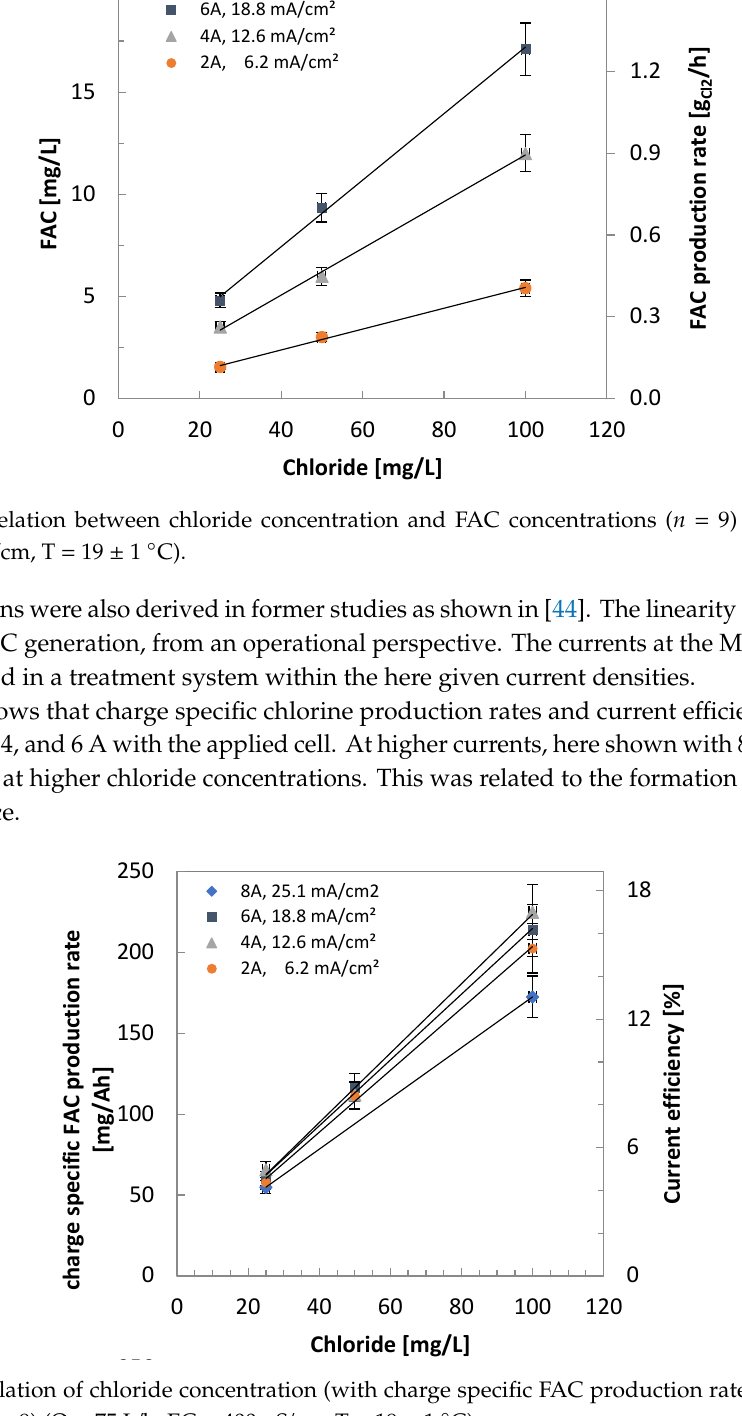
Figure 6. Relation of chloride concentration (with charge specific FAC production rate and current efficiency ( n = 9) (Q = 75 L/h, EC = 400 µS/cm, T = 19 ± 1 °C ). Figure 7 shows the linear relation between the electrolytically produced FAC concentration and the resulting reduction in FAC when irradiated with 1 and 2 UV reactors. Figure 7. Chlorine consumption by UV treatment in dependence of FAC (Q = 75 L/h, EC = 400 µS/cm, T = 19 ± 1 °C).